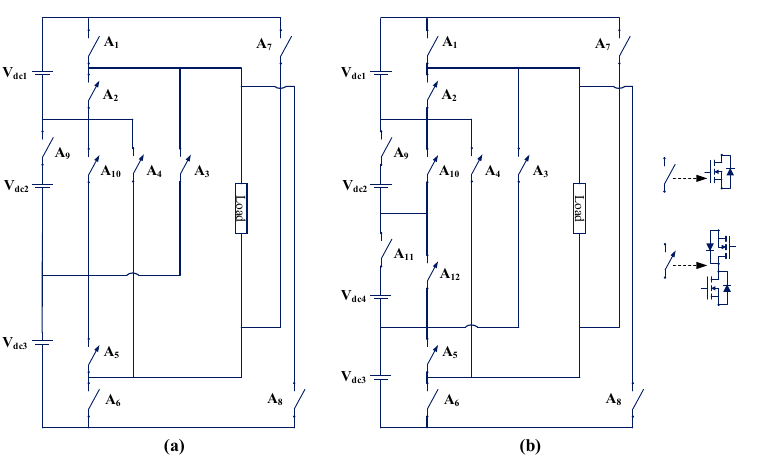
Figure 25. ( a ) Single-phase seven-level FT MLI (TP27). ( b ) Single-phase nine-level FT MLI (TP28) [60].